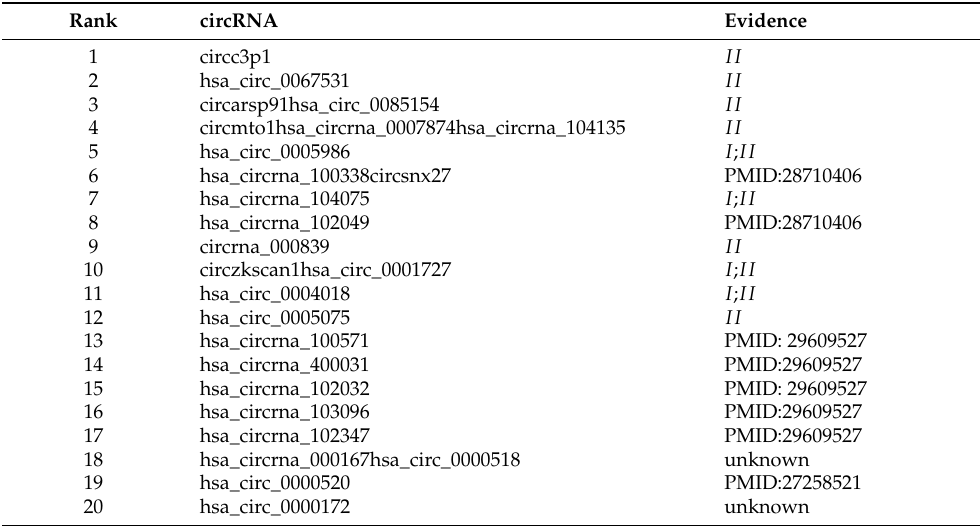
Table 5. Top 20 predicted circRNAs related to hepatocellular carcinoma based on circR2Disease